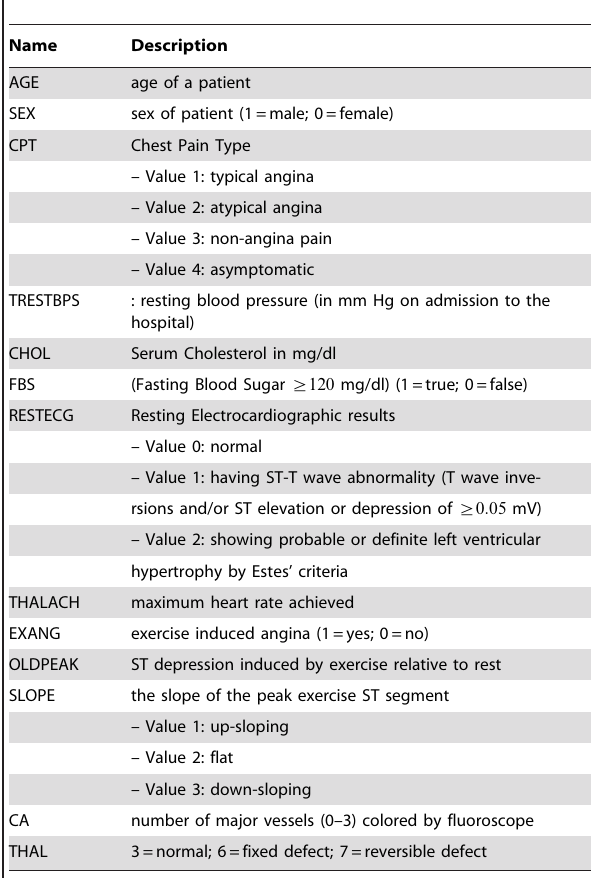
Table 3. The 13 symptom attributes used to predict HD in the